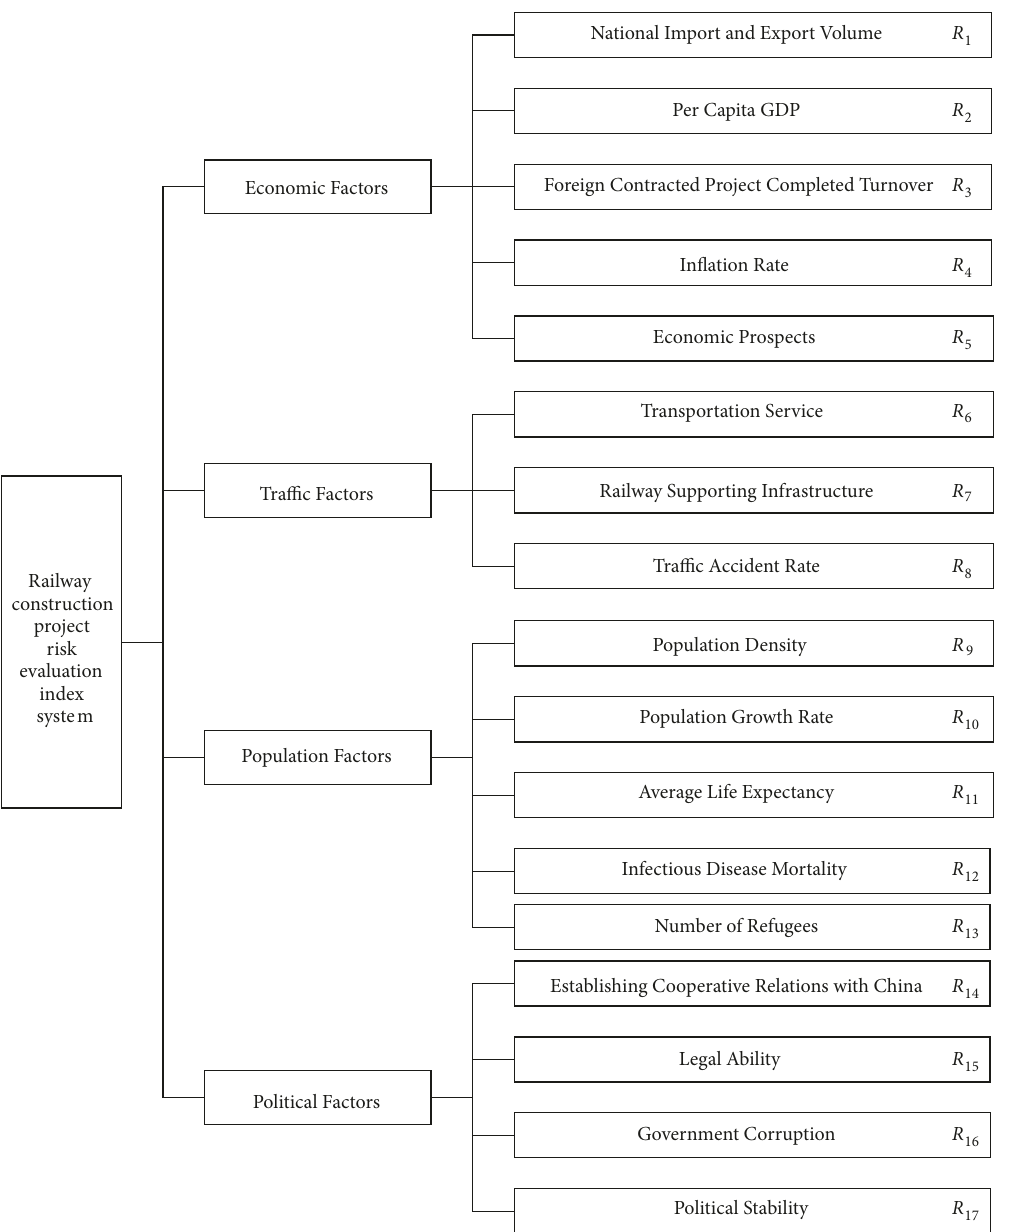
Figure 2: Railway construction project risk evaluation index